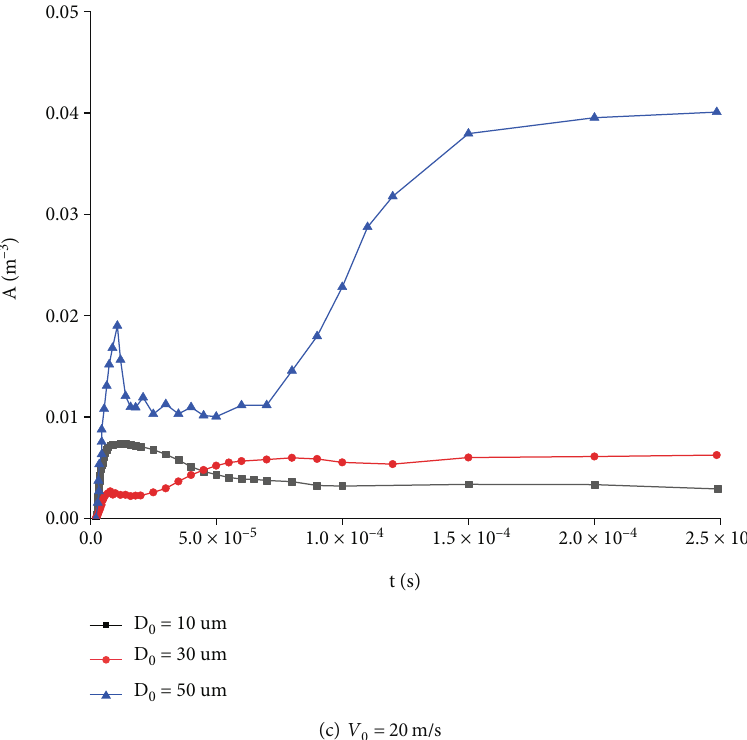
Figure 7: Variation of dimensionless spread area of di ff erent droplets with